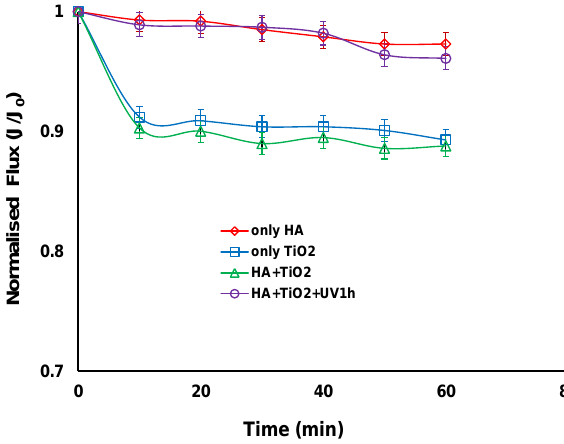
Figure 2. Normalised flux vs. time with different combinations of TiO 2 , humic acid (HA), with and without UV irradiation (TiO 2 concentration: 0.5 g/L, HA concentration: 20 mg/L, Transmembrane pressure (TMP): 100 kPa, Cross-flow Velocity (CFV): 0.4 m/s; pH: 7.5; UV intensity: 3.4 mW/cm 2 ).